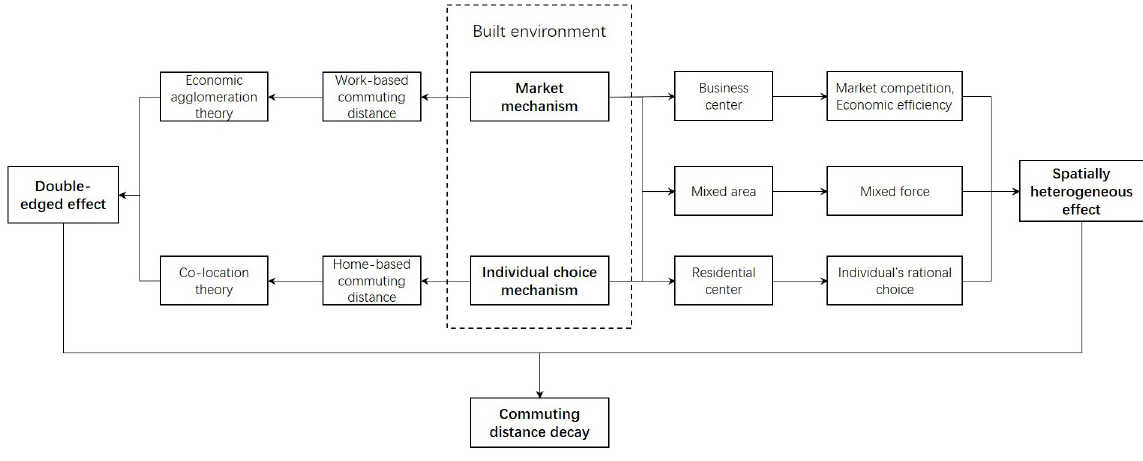
Fig 1. Conceptual